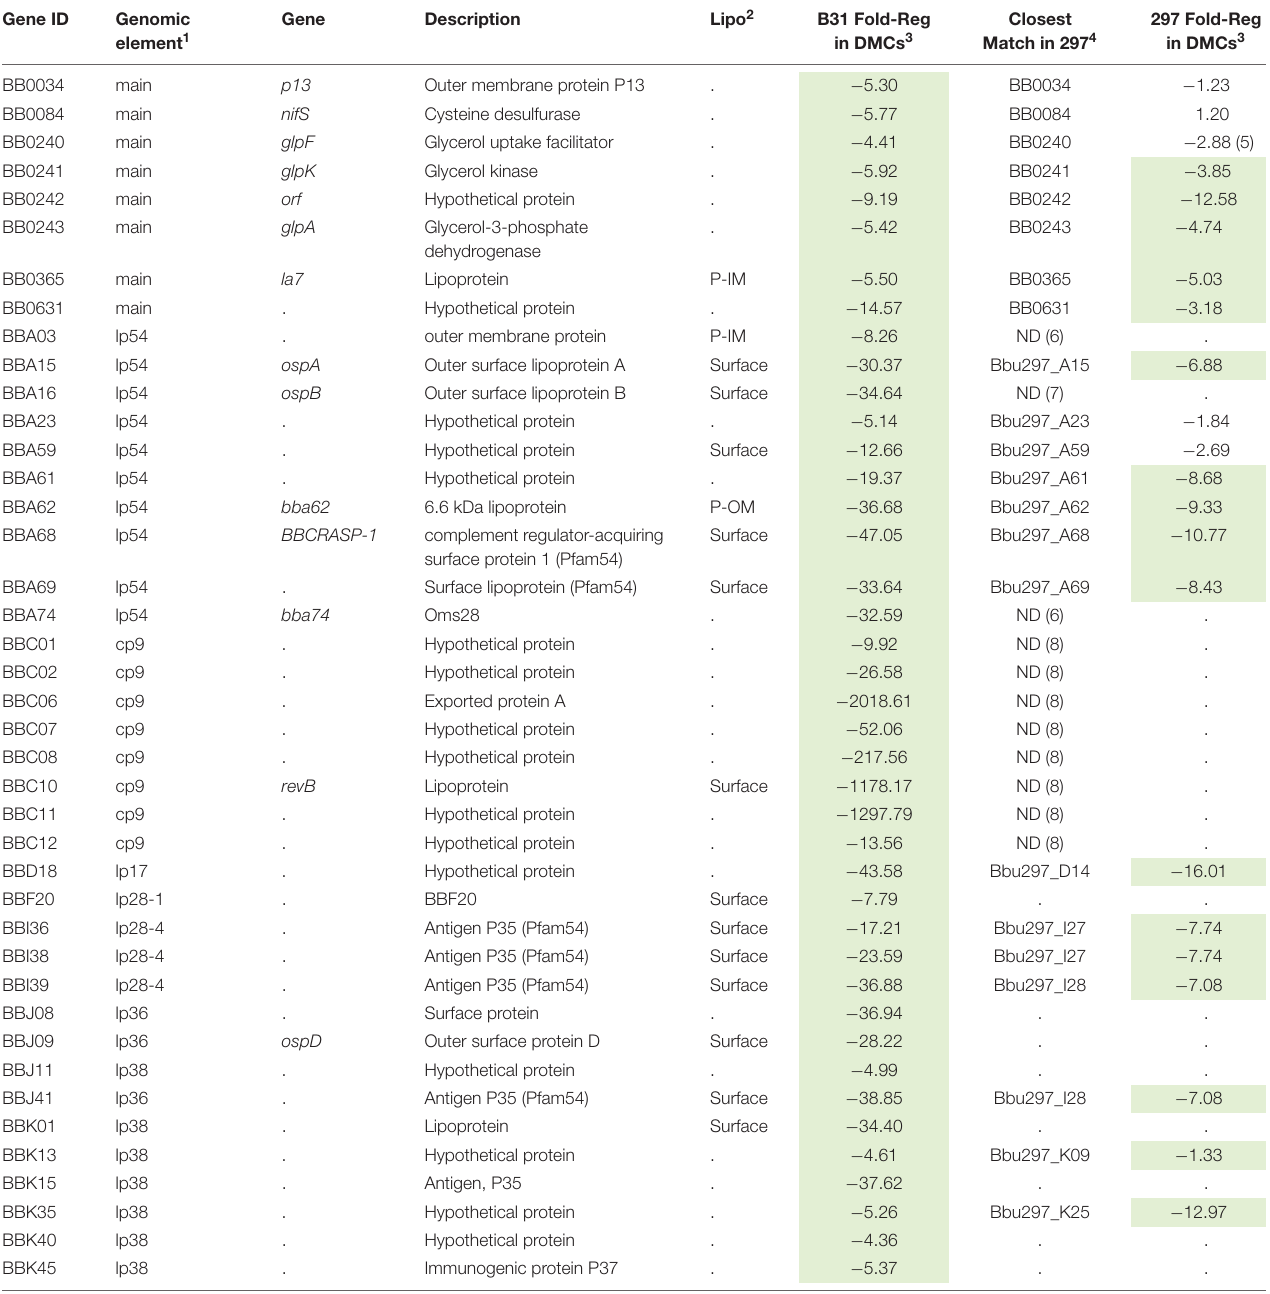
TABLE 3 | Genes repressed by RpoS in Borrelia burgdorferi in vitro and within DMCs. Gene ID Genomic element